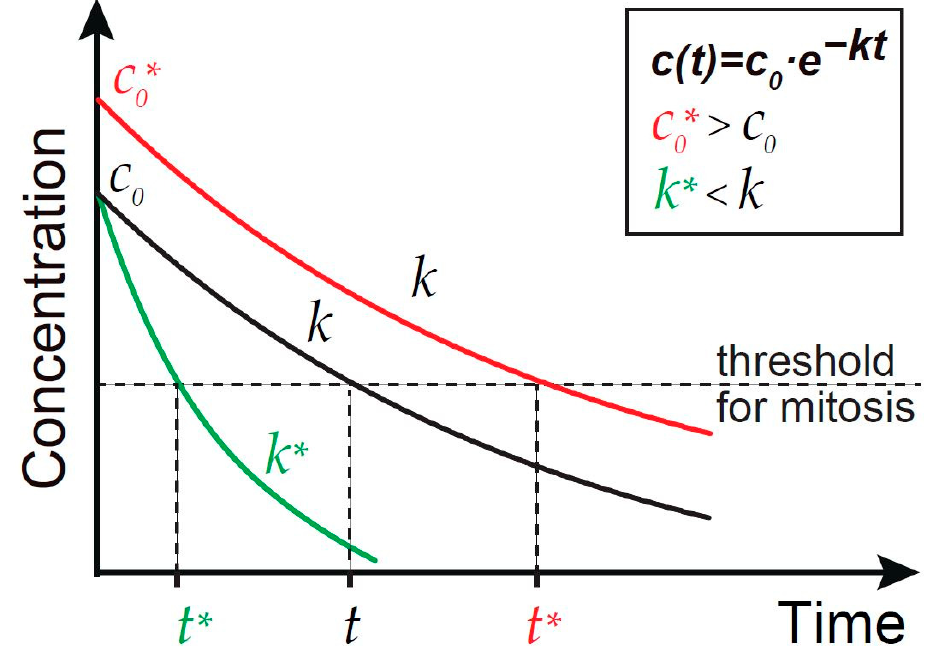
Figure 2. Gradients provide temporal information. Schematic time courses for wild type (black), c 0 * > c 0 (red), and k * < k (green). The formula is based on exponential fitting. c 0 , initial concentration. k , exponential constant. t , time to reach the threshold. t *, corresponding precocious or delayed time points.